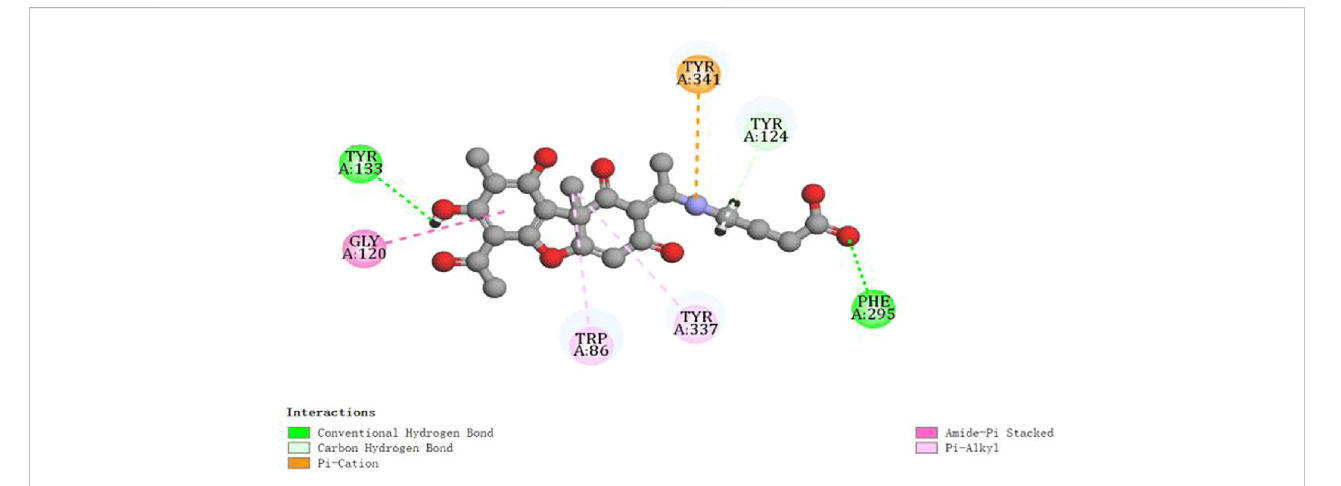
FIGURE 4 2D diagram of the ligand – protein interaction for compound 2 with